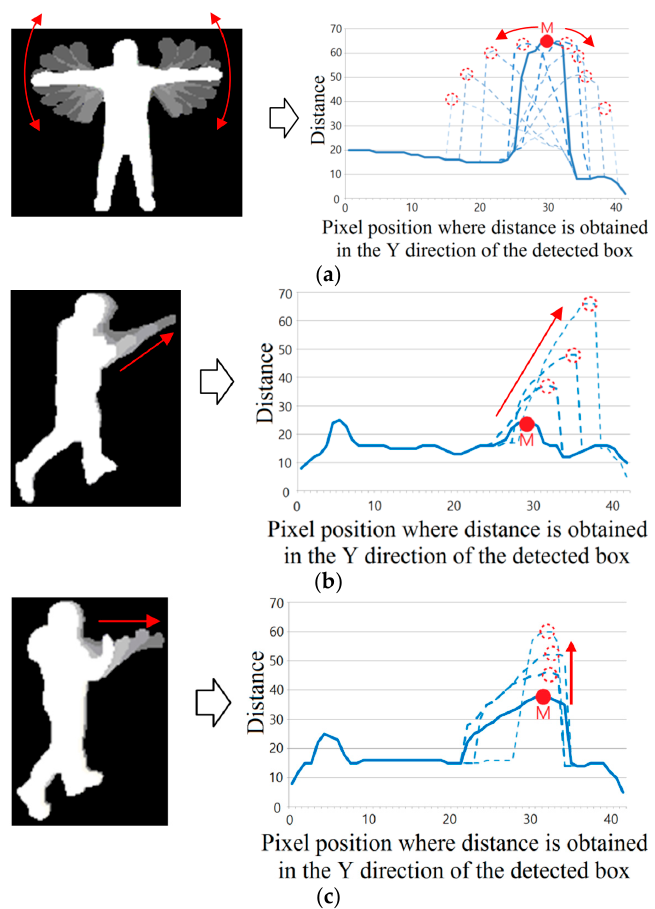
Figure 10. Examples of changes in the position of point M in the profile graph for hand waving and punching. ( a ) Hand waving (the figure on the right shows one profile graph among the two graphs representing the waving of both left and right hands); ( b ) punching (case 1); ( c ) punching (case 2). The proposed PbD method enables us to rapidly find the correct positions of the tips of the hand and leg without using a complicated algorithm that performs boundary tracking of binarized human area.